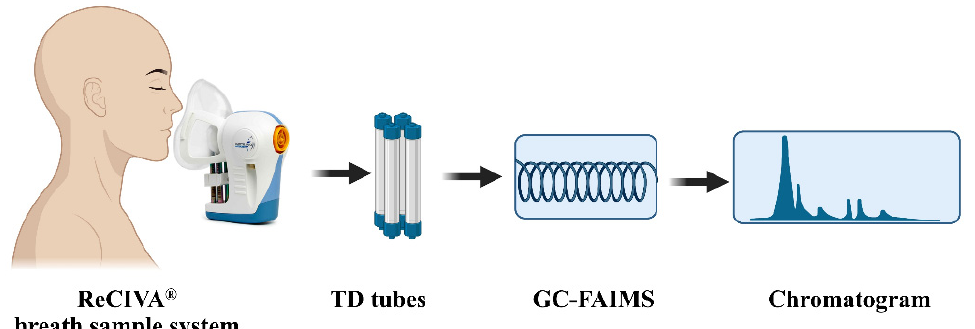
Figure 1. Schematic diagram of breath sample collection and breath sample analysis.